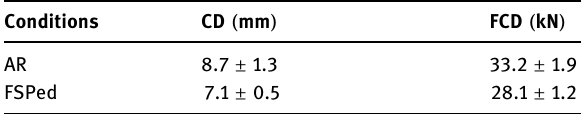
Table 2: CD and FCD of AR and FSPed